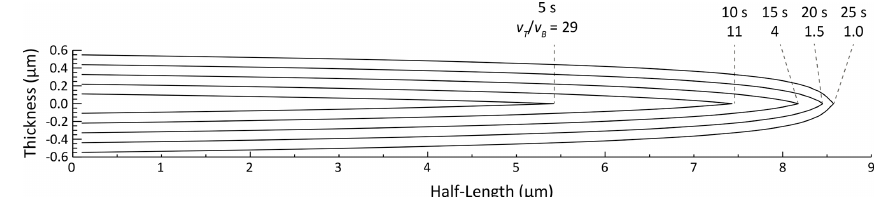
Figure 8. Approximate model of tip evolution and v T /v B for a constant-core model of an unannealed induced fission track. Each profile starts at the track center, starting from 5s after the beginning of etching for the innermost profile and proceeding in 5s increments to 25s for the outermost profile.